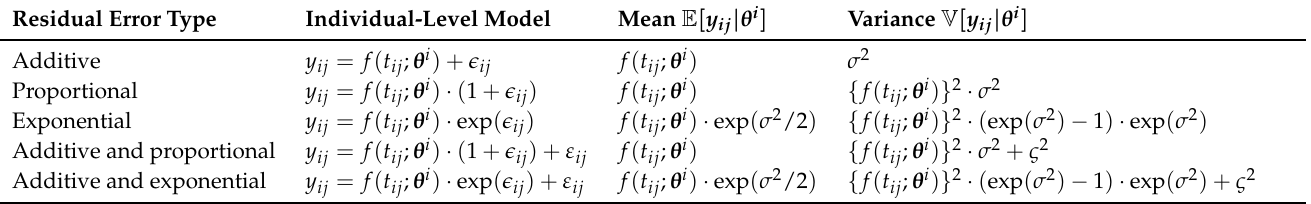
Table 3. List of residual error models that can be used in Stage 1